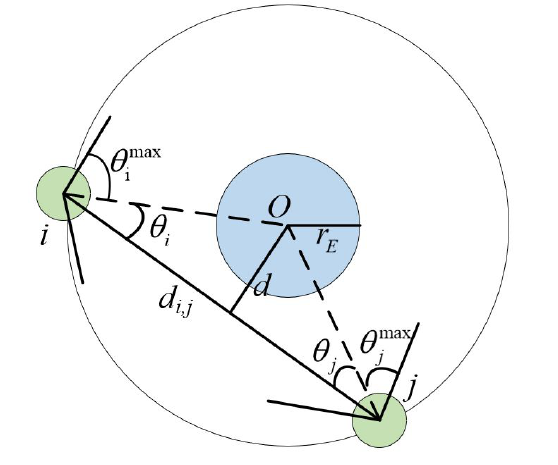
Figure 4. Visibility calculation